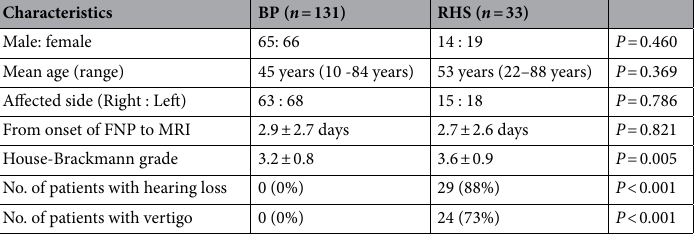
Table 1. Summary of clinical characteristics. BP, Bell’s palsy; RHS, Ramsay Hunt syndrome; FNP, facial nerve palsy; MRI, magnetic resonance